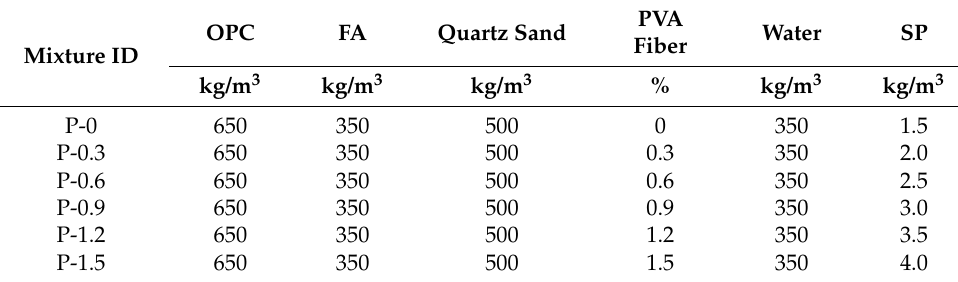
Table 4. Mix proportions of PVA-FRCC specimens.